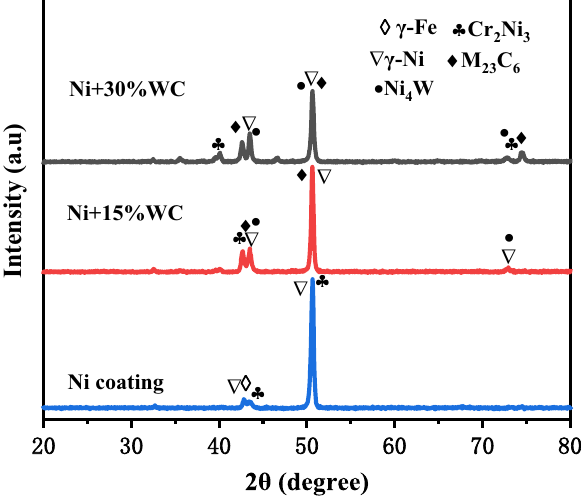
Figure 1: XRD spectra of pure Ni coating and Ni - based coatings with WC